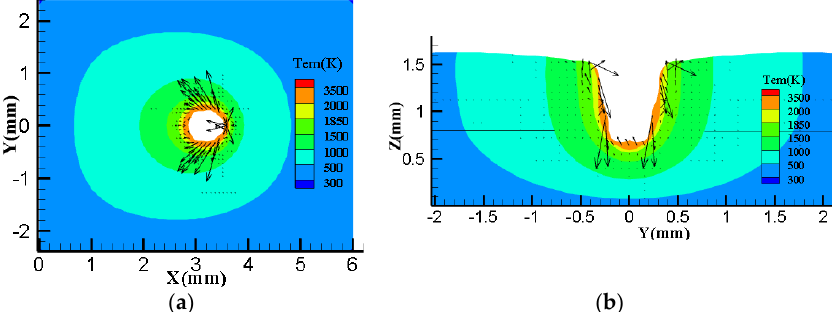
Figure 4. Calculated temperature and velocity fields in laser welding at time t = 28.35 ms (laser power 500 W, welding velocity 3.6 m/min): ( a ) top view; ( b ) cross ‐ section view. 500 W, welding velocity 3.6 m/min): ( a ) top view; ( b ) cross-section